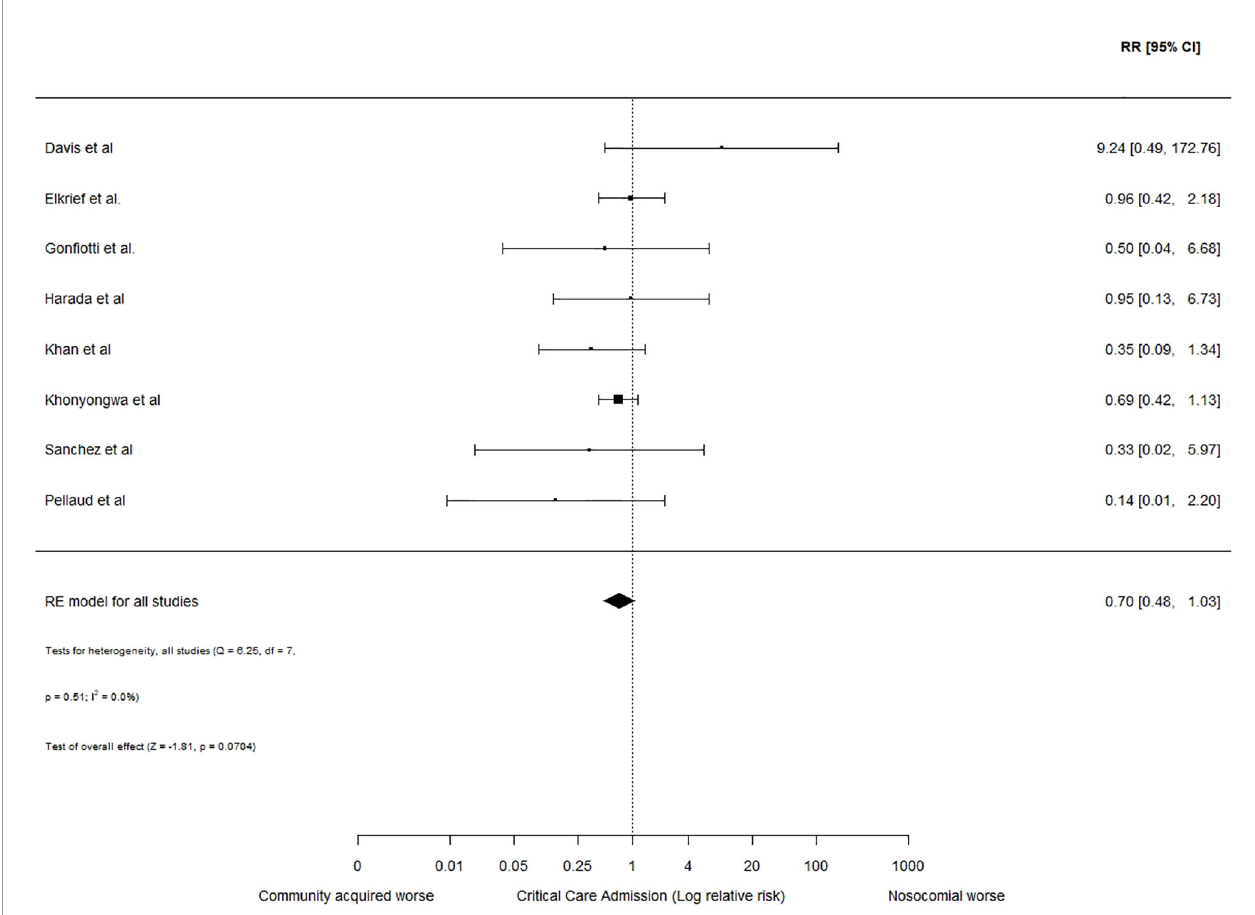
FIGURE 4 | Relative risk of critical care admission in hospitalized adults with nosocomial and community-acquired COVID-19. Forest plot assessing the relative risk (RR) and 95% con fi dence interval (95% CI) of critical care admission in adults hospitalized with community-acquired and probable nosocomial COVID-19. The size of each box is proportional to the size of the individual hospital site (A-N), with the error bars representing the 95% CIs. The diamond represents the pooled average across studies, based on a random effects (RE) model. I 2 : heterogeneity variance, calculated using restricted effects maximum likelihood